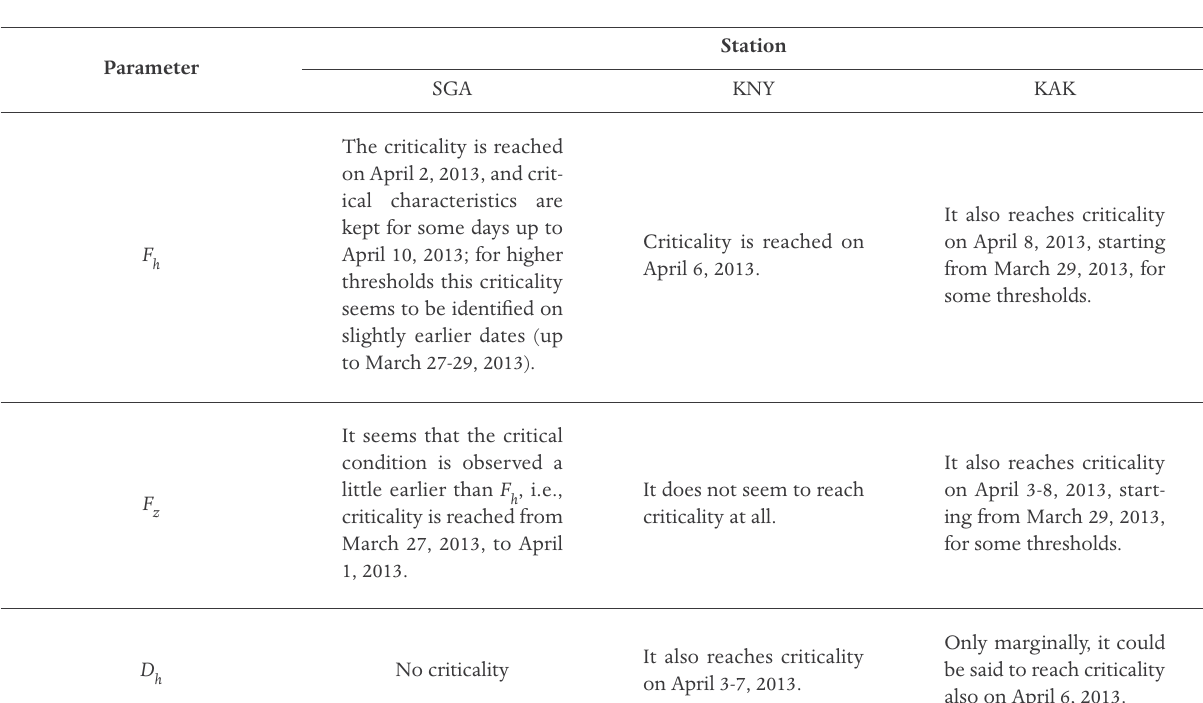
, F , and D at three magnetic stations (SGA, KAK, and KNY) for the April 12 h z h